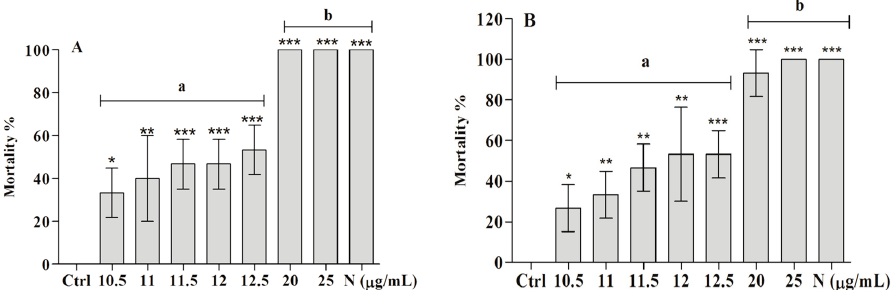
Figure 3. Molluscicidal activity ( µ g/mL) of the ether extract ( A ) and BAR ( B ) against B. glabrata snails. Ctrl—negative control (0.5% ethanol + filtered and dechlorinated water); N—niclosamide (1 µ g/mL). The significance levels of the differences compared with the negative control (ANOVA) are indicated with * ( p < 0.05), ** ( p < 0.01) and *** ( p < 0.0001). The letters “ a ” and “ b ” indicate that the groups did